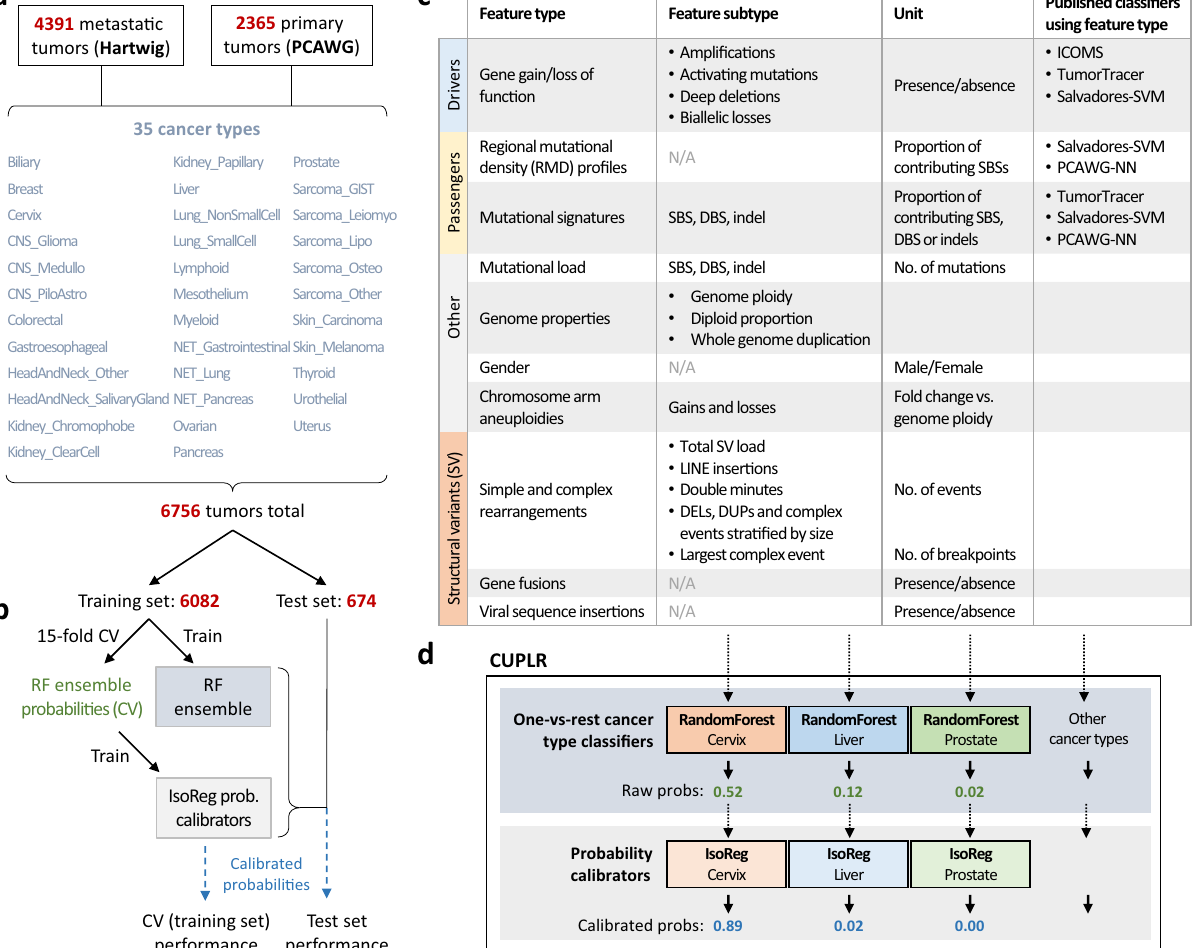
Fig. 1 Cancer of Unknown Primary Location Resolver (CUPLR) classi fi es 35 different cancer types using features derived from all mutation types. a CUPLR was developed using whole-genome sequencing data 4391 metastatic tumors from the Hartwig Medical Foundation (Hartwig) and 2365 primary tumors from the Pan-Cancer Analysis of Whole Genomes (PCAWG) consortium, totaling 6756 samples across 35 different cancer types. b 6082 samples were used to train CUPLR and 674 were held out as an independent test set. The whole training set was used to train the fi nal random forest ensemble. 15- fold cross-validation was performed to obtain the random forest cancer type probabilities on the training set, which were then used to train the ensemble of isotonic regressions (for probability calibration). CUPLR is composed of the random forest and isotonic regression ensembles as shown in d . The performance of CUPLR was assessed using the calibrated cross-validation probabilities as well as probabilities obtained by applying CUPLR to the test set. c A summary of the genomic features extracted from the whole-genome sequencing data and used by CUPLR. Detailed descriptions of each feature can be found in Supplementary data 3. The names of the published classi fi ers refer to the following studies: ICOMS Inferring Cancer Origins from Mutation Spectra, Dietlen et al. 4 , TumorTracer Marquard et al. 5 , Salvadores-SVM support vector machine by Salvadores et al. 7 , PCAWG-NN PCAWG